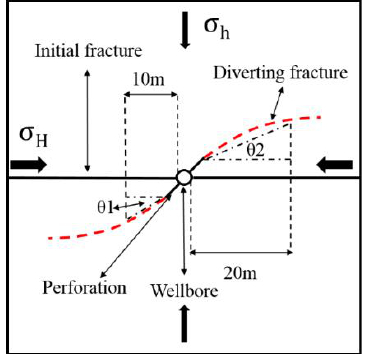
Figure 5. Schematic diagram of deflection angle.